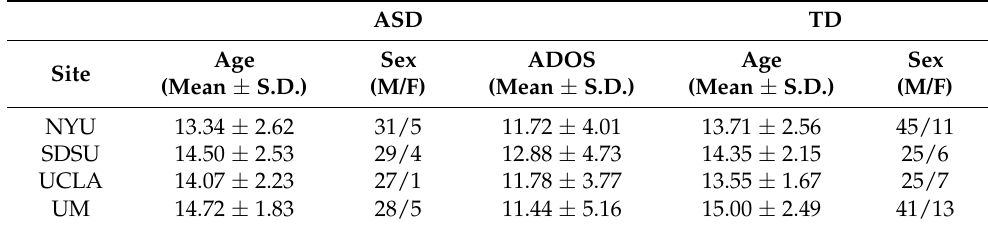
Table 1. The demographic information of our datasets.